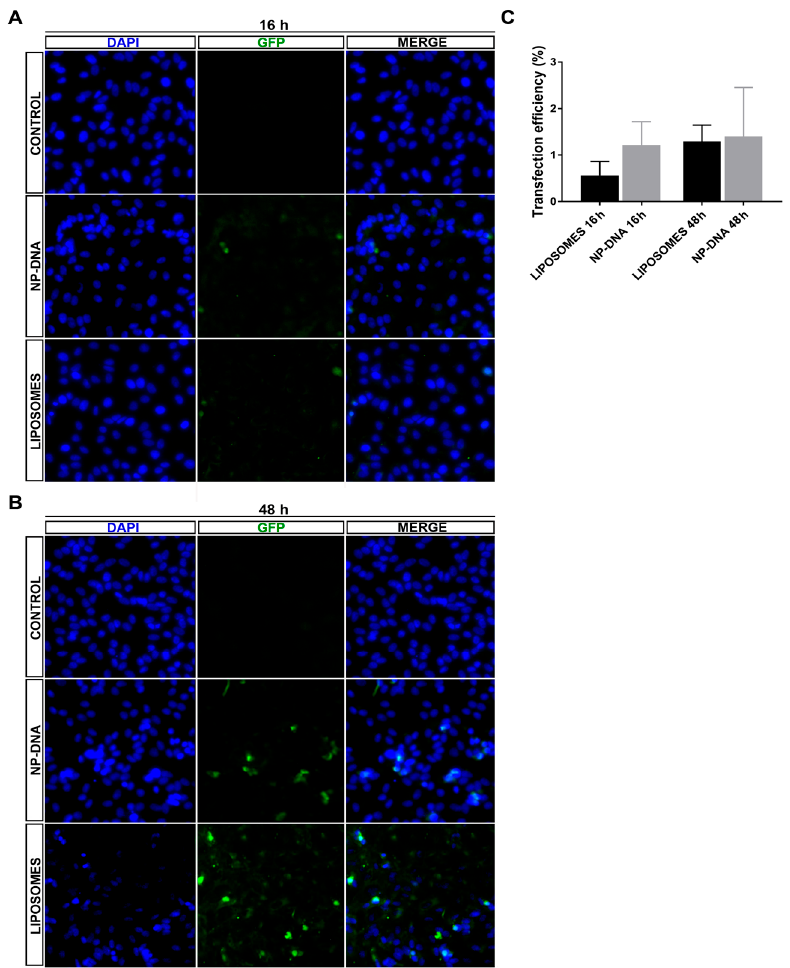
Figure 1. Analysis of transfection efficiency of DNA-wrapped gold nanoparticles (40 nm) compared to liposomes in differentiated ARPE-19 cells. Representative images of differentiated ARPE-19 cells transfected with the pEGFP reporter vector using either liposomes (LIPOTRANSFECTINE) or nanoparticles at ( A ) 16 h and ( B ) 48 h (for wider field images with a lower amplification, see Supplementary Materials, Figure S1). ( C ) Quantification of green fluorescent protein (GFP)-positive cells showed similar levels of transfection efficiency by nanoparticles (1.4% positive cells using 0.25 μ g/150,000 cells) compared to standard lipofection (1.31% positive cells using 0.5 μ g/150,000 cells) at 48 h. Remarkably, nanoparticles promoted GFP expression in transfected cells at an earlier time after transfection compared to liposomes, since at 16 h, 1.2% cells were GFP-positive in nanoparticle-transfected cells compared to 0.54% in those transfected with liposomes, thus suggesting different cellular uptake and/or intracellular vesicular trafficking routes for the two transfection systems. Quantification on 1100–1600 cells per condition.